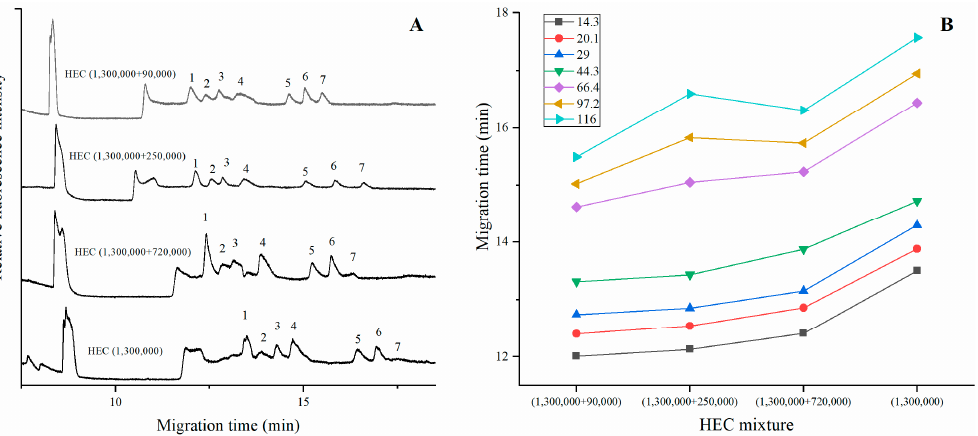
Figure 1. ( A ) The electropherogram of proteins separation in HEC (1,300,000) mixed with other M r of HEC; ( B ) The migration times varied with the mixed solution. Experimental conditions: the samples were loaded at 100 V/cm (90 s); the electric field strength was 100 V/cm. The total length and the effective length of the capillary are 15.0 cm and 12.0 cm, respectively. The solutions were mixed with a ratio of 5/5. The peaks were characterized as follows: 1. lysozyme (14.3 kDa), 2. trypsin inhibitor (20.1 kDa), 3. carbonic anhydrase (29.0 kDa), 4. ovalbumin (44.3 kDa), 5. serum albumin (66.4 kDa), 6. phosphorylase B (97.2 kDa), and 7. β -galactosidase (116.0 kDa).